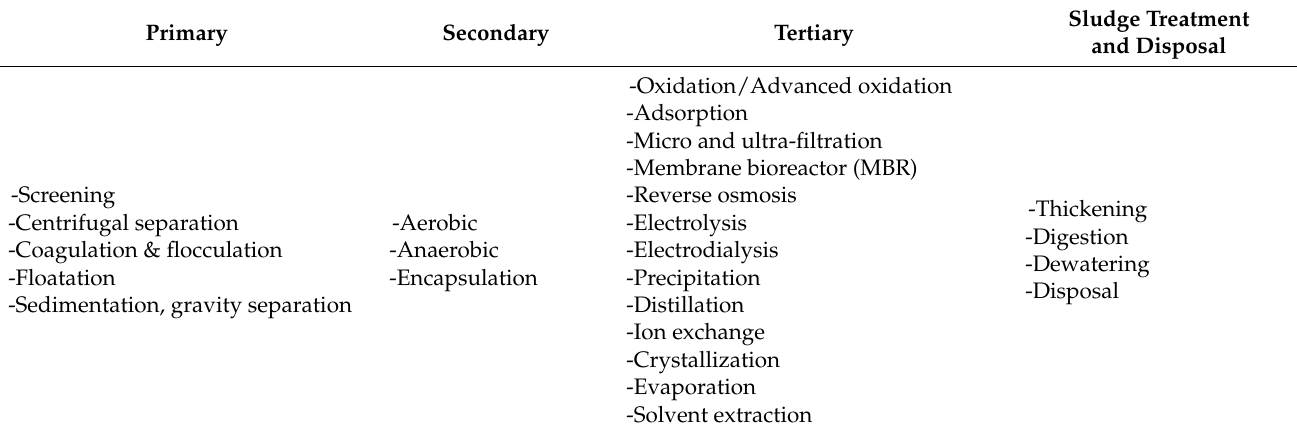
Table 3. Overall scheme of wastewater treatment technologies.